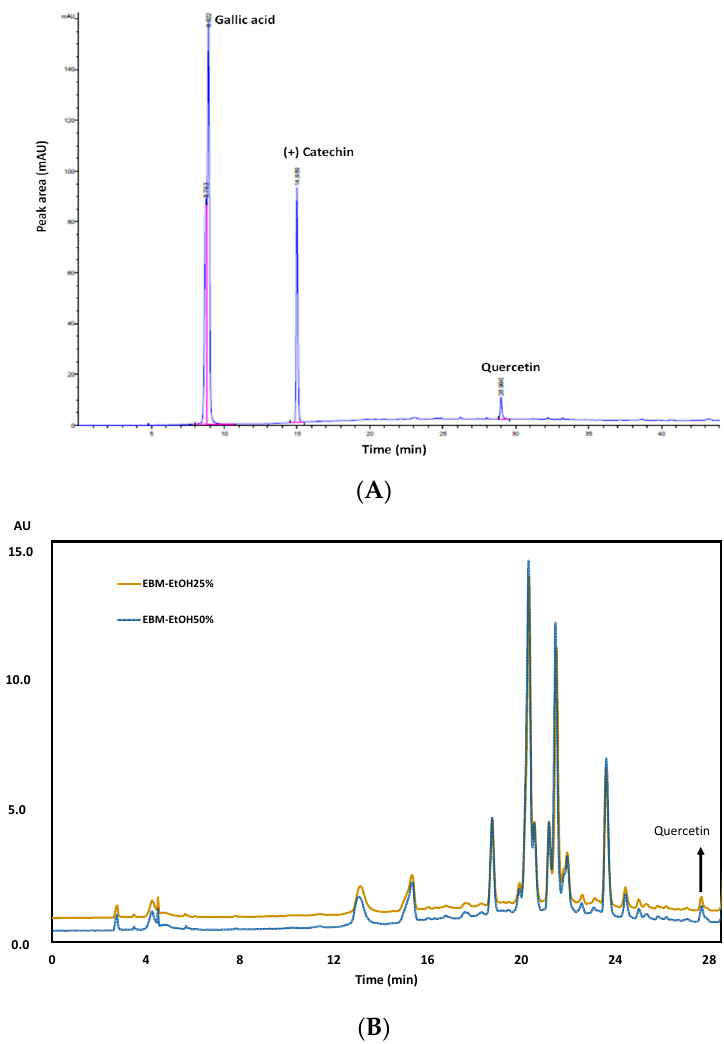
Figure 6. Analysis UHPLC of extracts of Baccharis macrantha . ( A ) Gallic acid, catechin, and quercetin standards ( B ) EBM-EtOH25% and EBM-EtOH50%. ( λ = 366 nm). Simões-Pires et al. [63] have identified polyphenolic and flavonoid compounds in aqueous extracts of B. trimera , B. crispa , and B. usterii . The main compound identified in all three species was quinic acids esters. Isoquercetin and quercetin compounds were identified in B. trimera . These two flavonoids were detected by HPLC-MS as the abundant compounds in B. trimera . Moreira et al. [21] have identified flavonoid compounds in methanolic extracts of B. pseudotenuifolia , using the TLC technique. Among the identified compounds, quercetin, 3 (cid:48) -methoxy-quercetin, quercetin-3-O-rhamnoside and, quercetin-3-O-glucoside were found. Different flavonoid compounds have been described in Baccharis species. The quercetin compound has been identified in species such as B. grisebachii , B. latifolia , B. illinita, and B. pseudotenuifolia [19]. Saber et al. [49] have identified and quantified gallic acid (45.8 ± 7.2 mg/g), rutin (15.1 ± 2.5 mg/g), and quercetin (5.1 ± 1.4 mg/g) in extracts of B. trimera ; the identification was made by HPLC technique. Wollenweber et al. [64] have identified flavonoid compounds from extracts of B. concinna , B. confertifolia , B. linearis , and B. lycioides . Within these compounds, they identified quercetin, quercetin 3-Me, quercetin 7-Me, and other isoforms. The differences in the identifications of the compounds may be due to the species of Baccharis , the way of obtaining the extracts, and the type of analysis used for the identification.